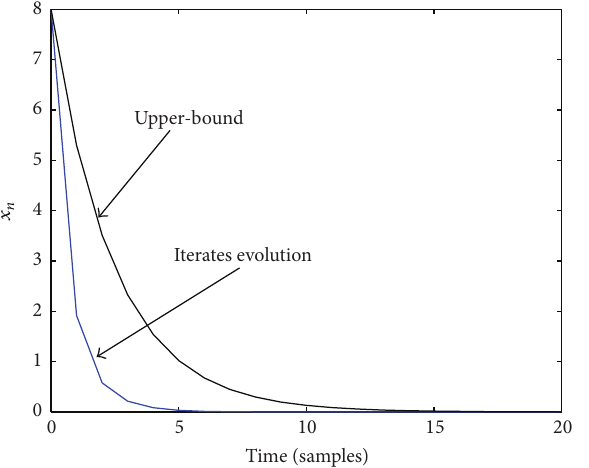
Figure 4: Iterates for different initial conditions and weights defined by